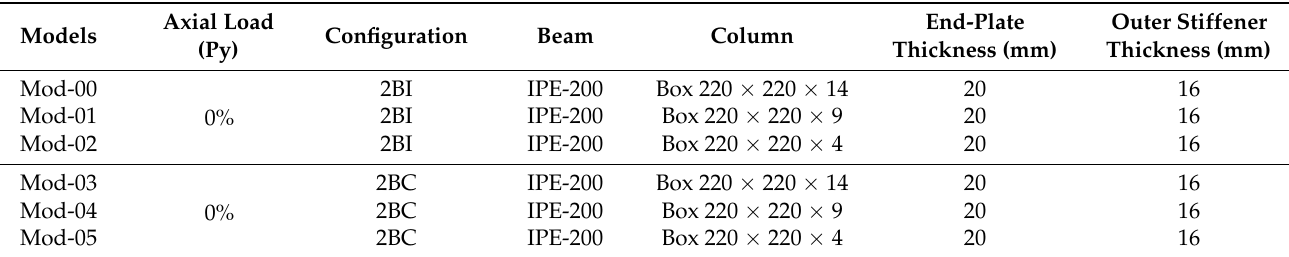
Table 3. Geometrical dimensions of the